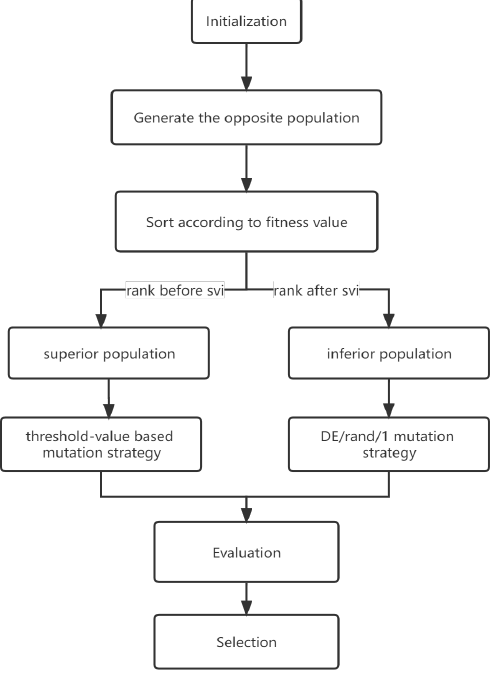
Figure 1. Flowchart of Bi-mutation Strategy